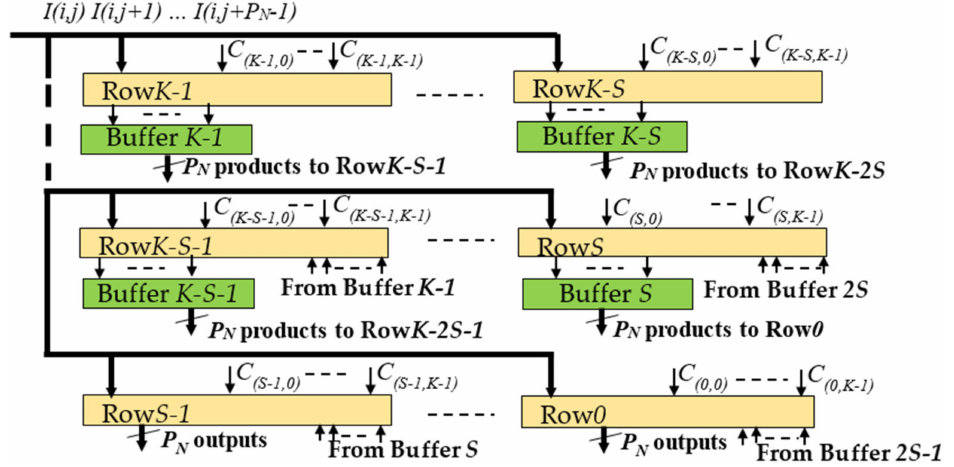
Figure 5. The structure of the generic